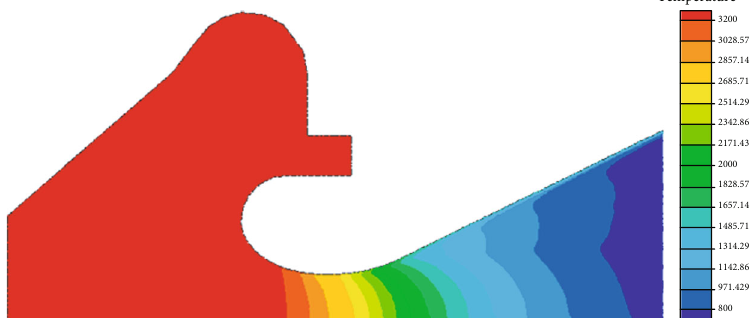
Figure 4: Temperature distribution about the steady fi eld of SRM, K.